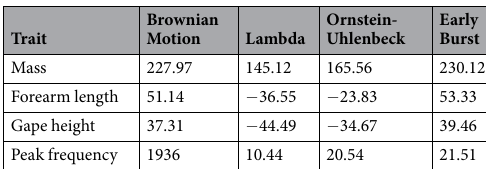
Table 1. The fit of different evolutionary models (AICc values are